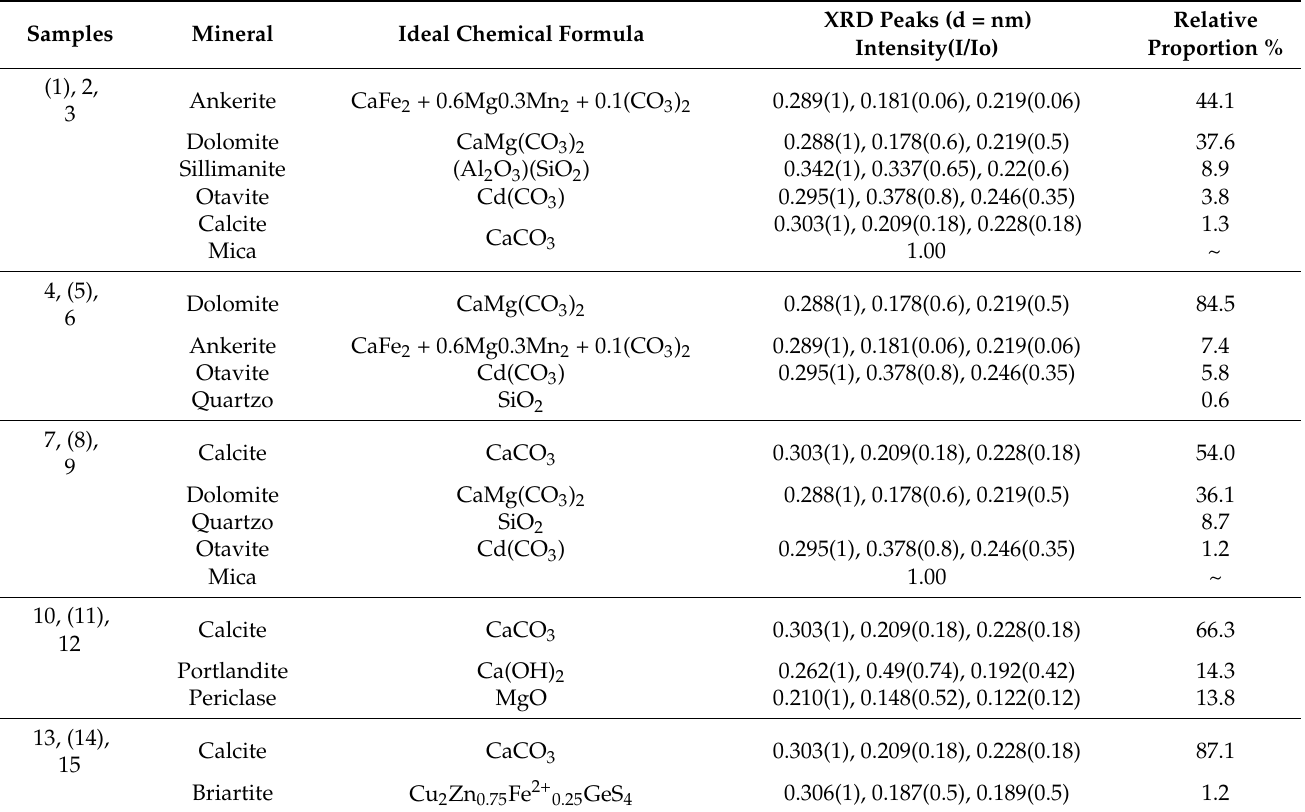
Table 2. Mineral composition and quantification based on the X-ray diffraction (XRD) patterns from limestone/corrective powder